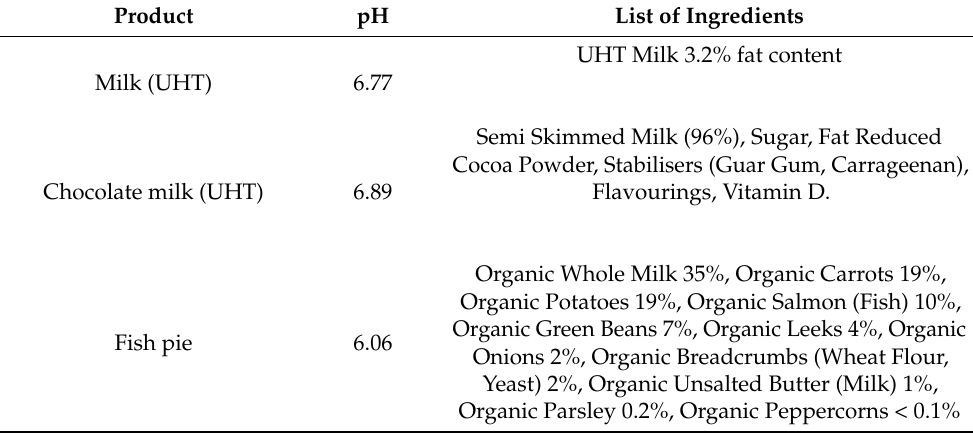
Table 1. Details of test food